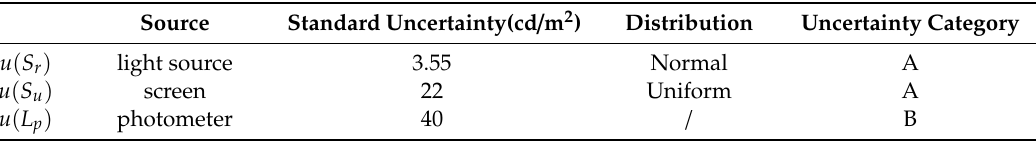
Table 5. Summary of uncertainty compositions.